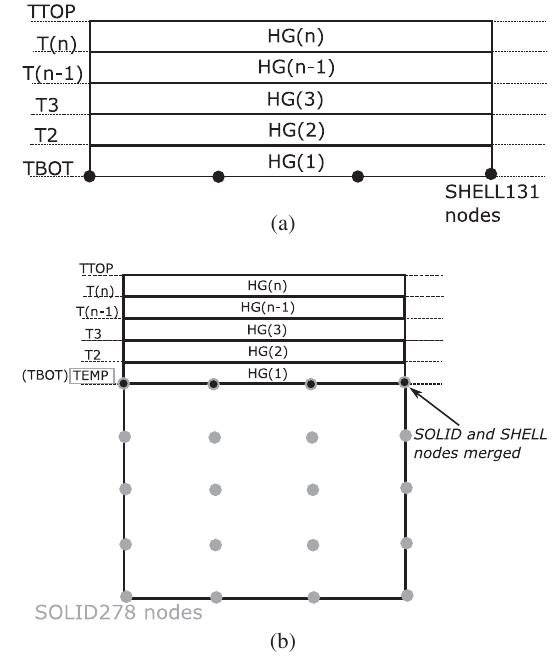
FIG. 2. (a) Layered shell elements offset to bottom. Each layer has its own heat generation (HG) profile. The temperatures are evaluated as d.o.f. from the shell bottom (TBOT) to the shell top (TTOP). (b) Hybrid model. The shell is offset to bottom. TEMP: d.o.f of a solid-element We implement initial time step lengths smaller than l 2 = ð 4 α Þ [12] where l is the size of the smallest element edge, α the thermal diffusivity rate given by α ¼ k= ð ρ c p Þ at room temperature.